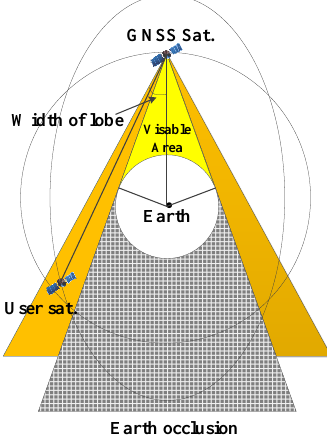
Figure 3. GNSS satellite geometry visible schematic.